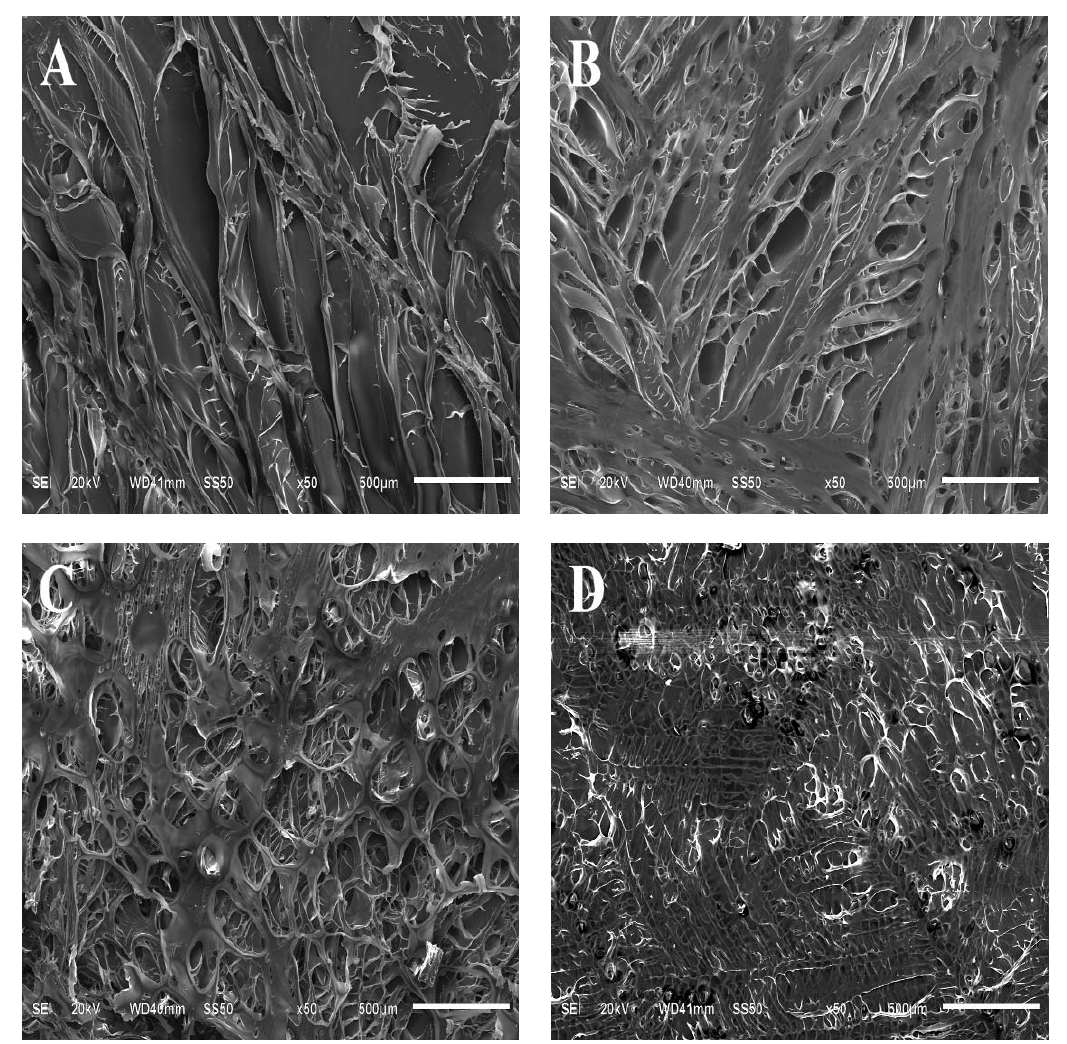
Figure 2. SEM images of the outer surfaces of ( A ) CS; ( B ) PCLA- Ι (LA: CS = 2:1, w/w);